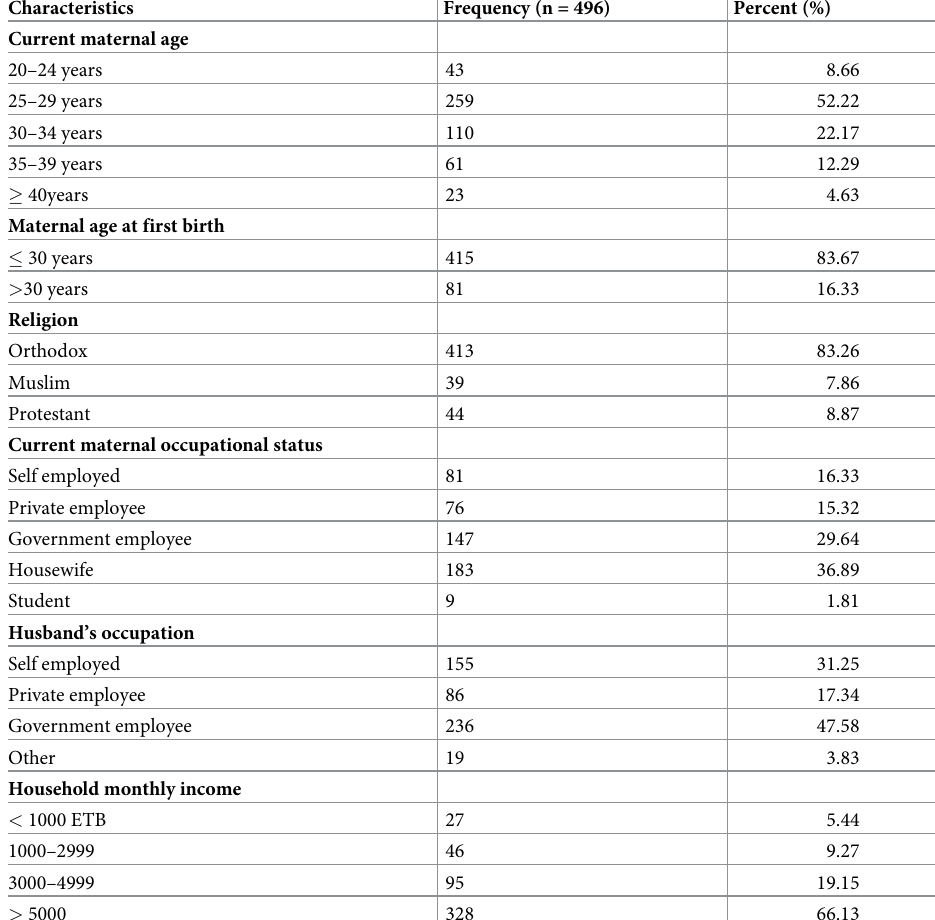
Table 1. Socio-demographic characteristics of the study participants, Debre Berhan town, Amahra region, Ethio- pia, 2020.